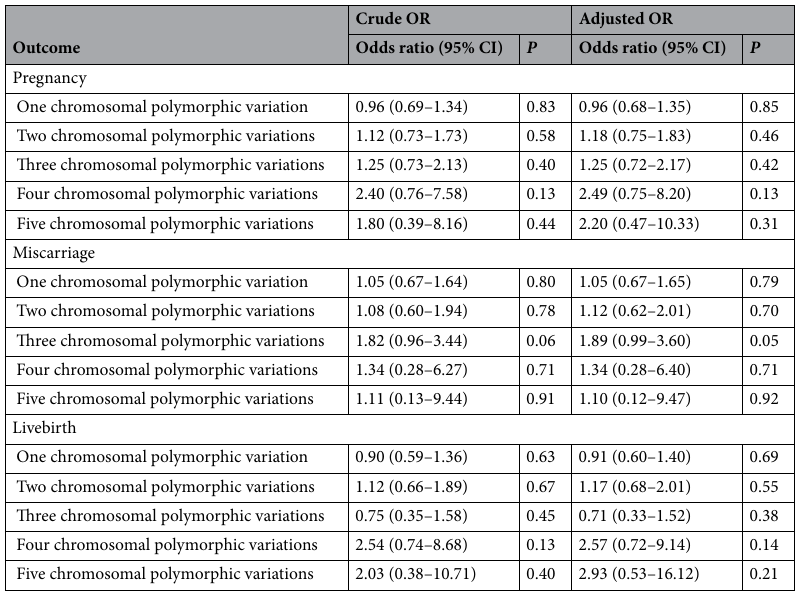
Table 7. Crude and adjusted odds ratio for pregnancy of the number of polymorphic variations in the study population. The reference category is no chromosomal polymorphic variations in either partner. Reproductive outcomes are adjusted for confounding variables including age, BMI, serum FSH, LH levels, and type of treatment. OR Odds ratio. CI 95% Confidence